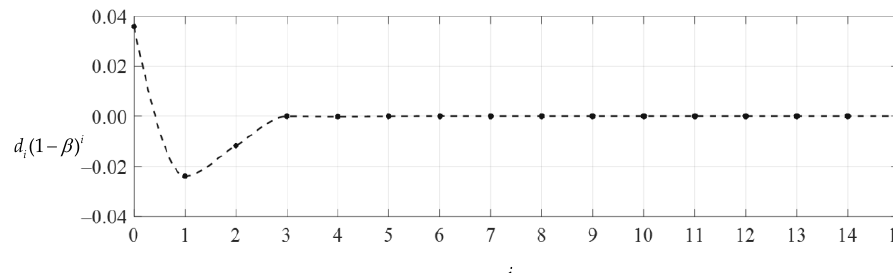
Figure 8. Variation of c i ( α − β ) i with i .